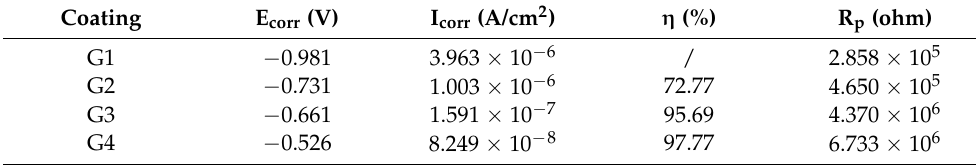
Table 7. Kinetic parameters of each coating in seawater of 40% concentration for 90